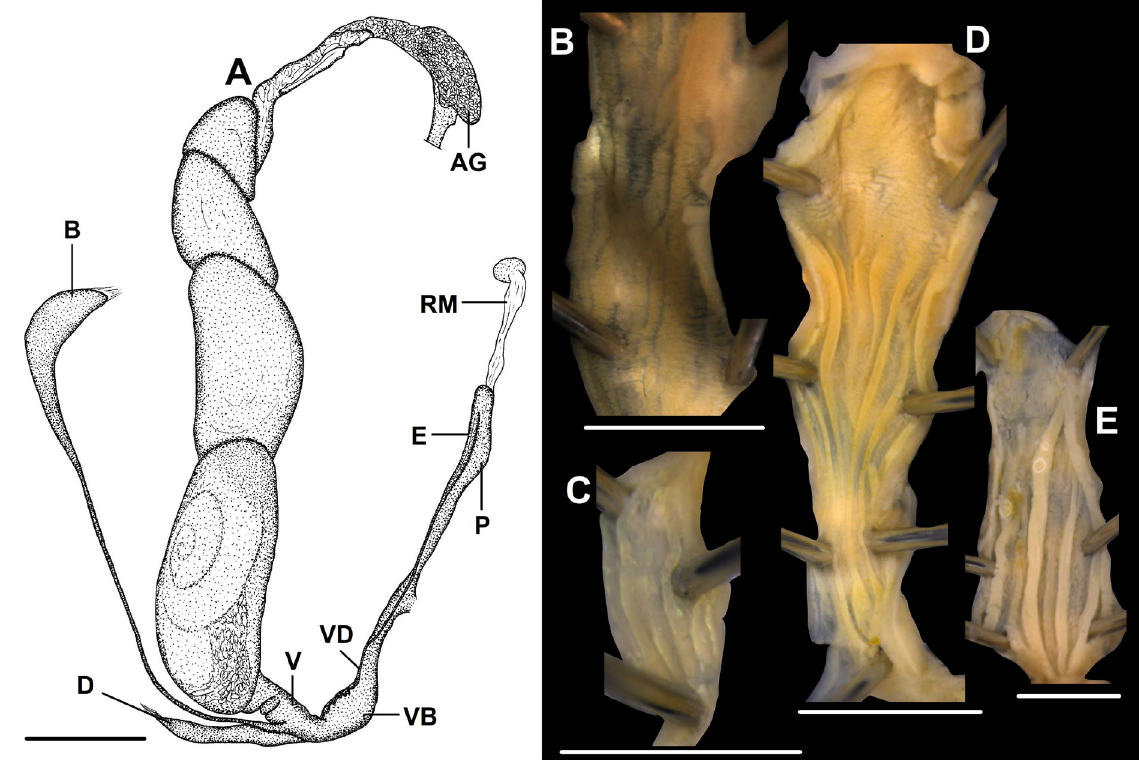
Fig. 45. Genitalia of Plectopylis malayana sp. nov., PL010 (NHMUK 20170153). A . Whole genitalia. B–E . Inner structure of genital organs (B = penis, C = epiphallus, D = vagina, E = diverticulum). Scale bars: A = 5 mm; B–E = 1 mm. For abbreviations see Fig. 2. All photos: B.